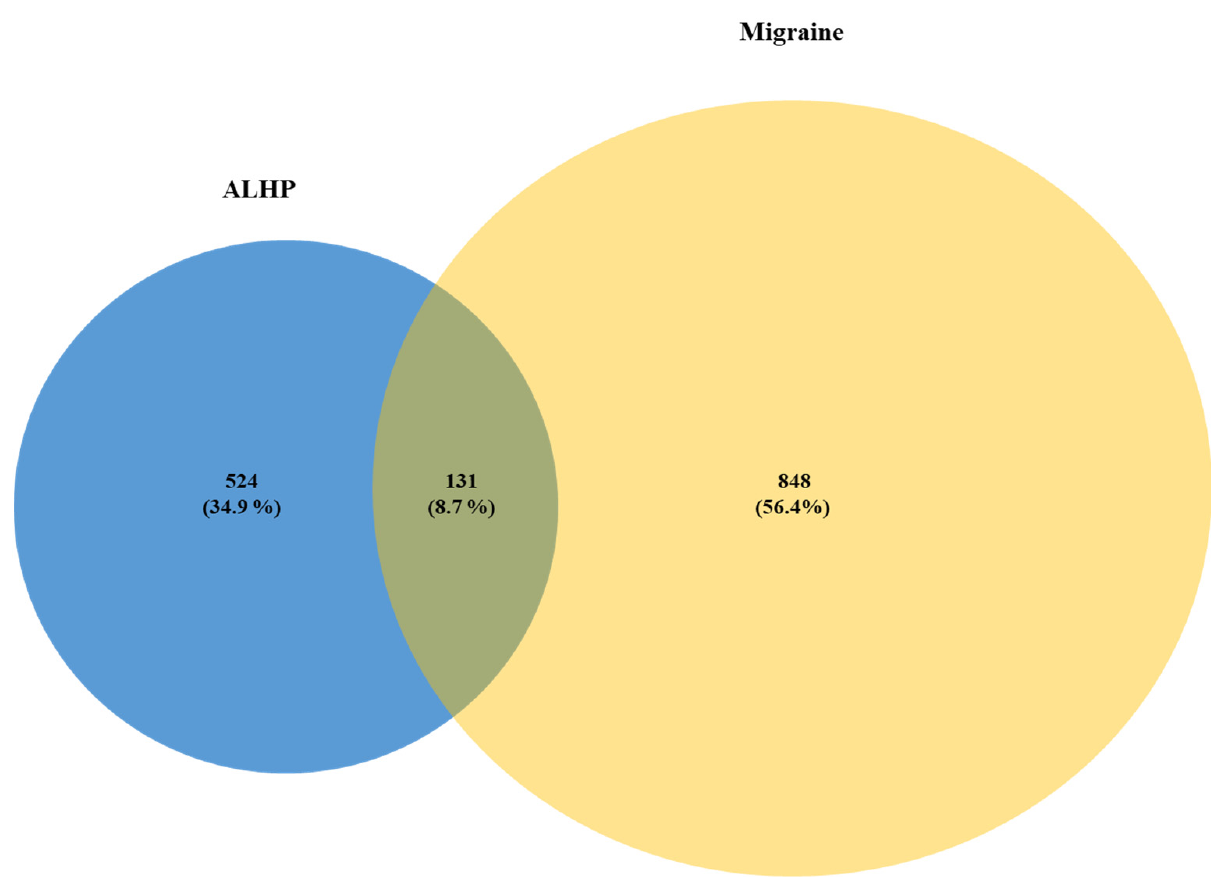
Figure 1. Venn diagram of the overlapping target of ALHP and migraines.